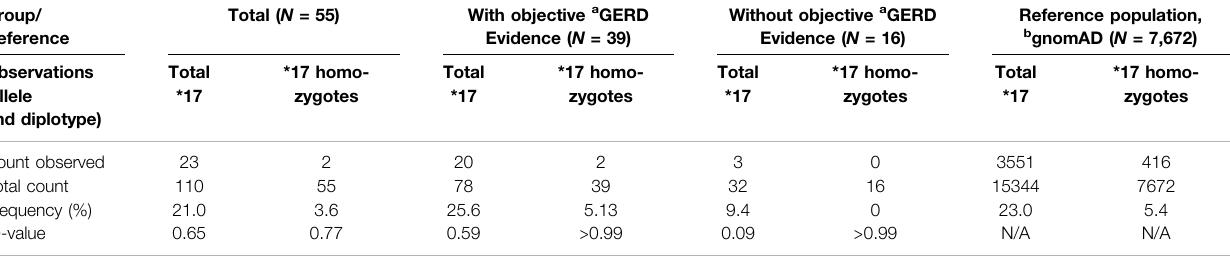
TABLE 2 | Group comparison of genotype and diplotype of CYP2C19*17 between reference population and cases (overall and within subgroups). Group/ Reference